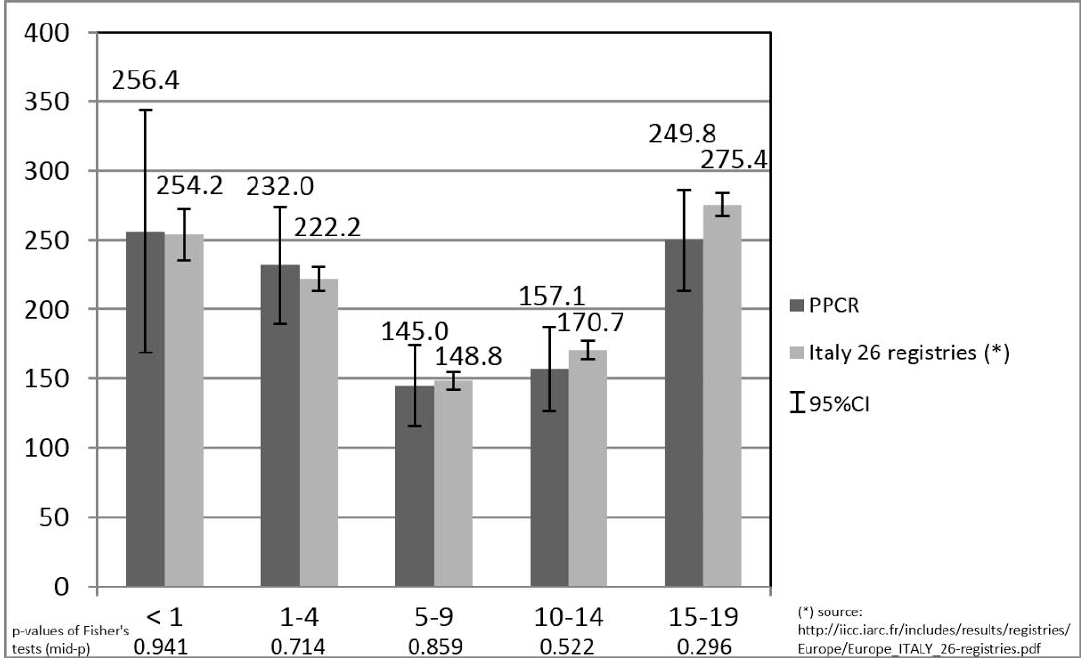
Figure 1. Age ‐ specific incidence rates of paediatric tumours (males and females together): comparison between Palermo Province Cancer Registry (2003–2012) and “Italy 26 registries” (1992–2013). Figure 1 legend. PPCR: Palermo Province Cancer Registry; 95%CI: 95% Confidence Intervals.